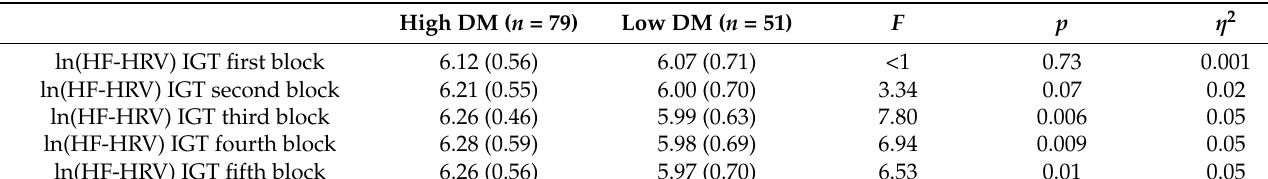
Table 3. Means (M) and standard deviations (SD) of ln(HRV) in decision-making (DM) groups.